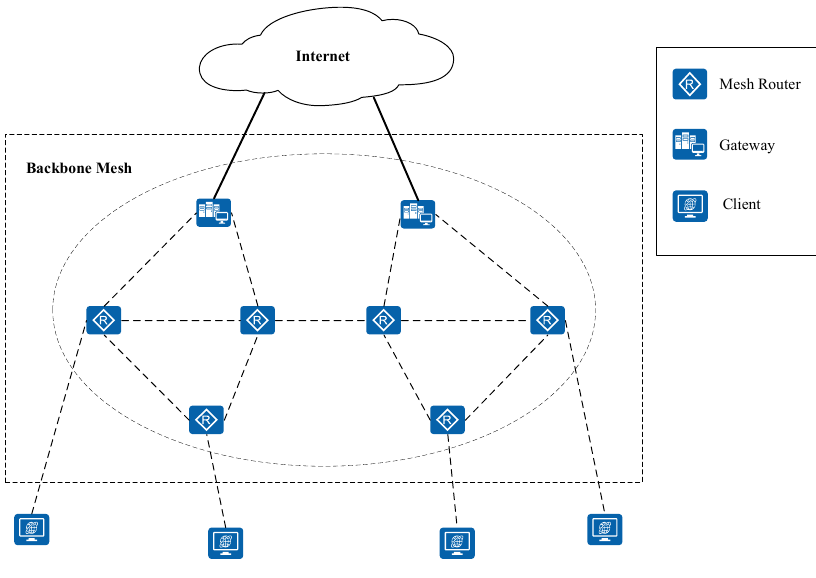
Figure 1. Structure of wireless mesh networks.